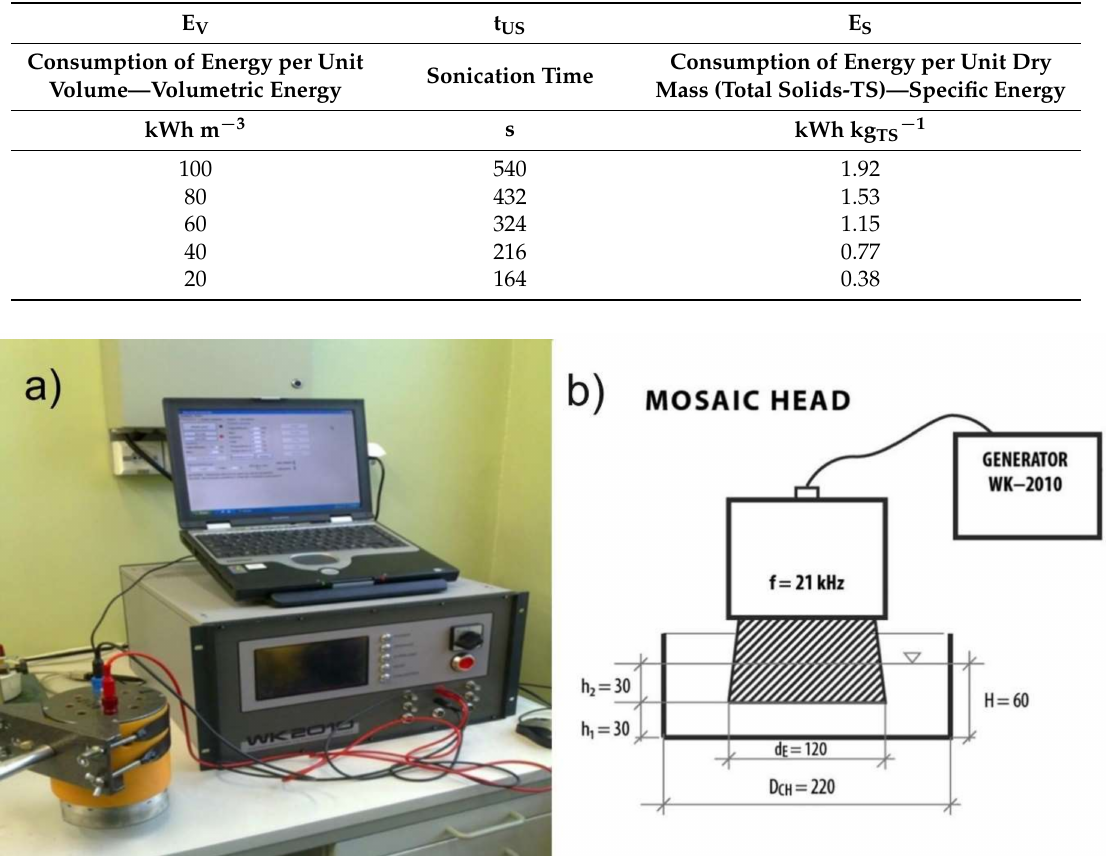
Figure 3. Ultrasonic disintegrator setup—WK-2010 ultrasonic generator with mosaic head: ( a ) photo; ( b ) scheme